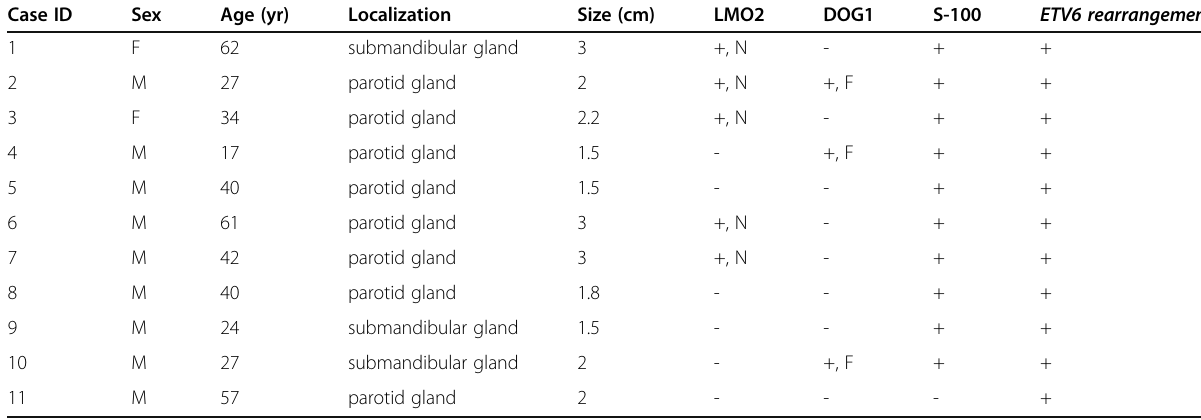
Table 2 Clinical and pathological features of SCs of salivary